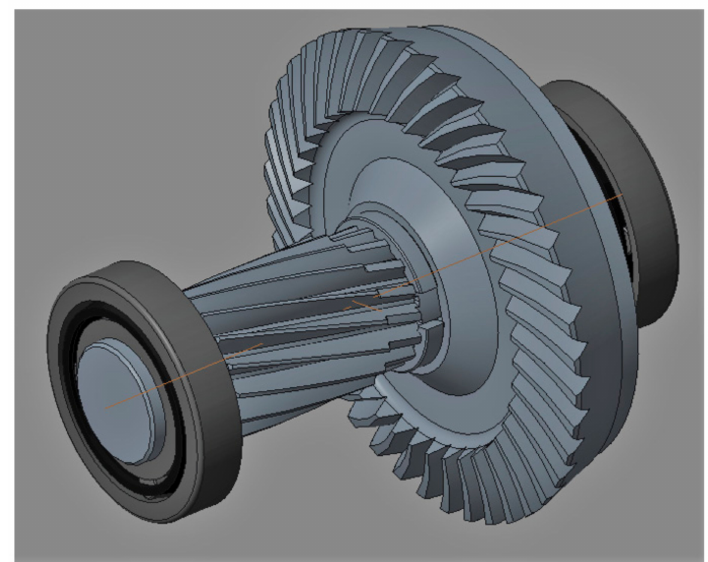
Figure 3. One of the four subgroups composed of a shaft, gears, and